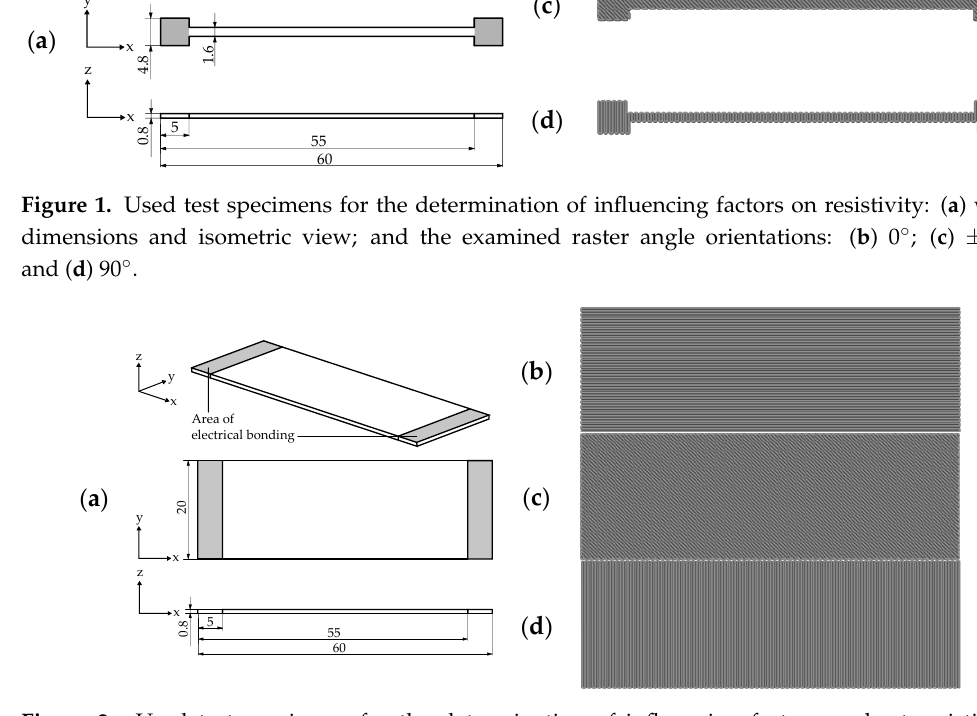
Figure 2. Used test specimens for the determination of influencing factors on heat resistivity: ( a ) with dimensions and isometric view; and the examined raster angle orientations: ( b ) 0°; ( c ) ±45°; and ( d ) 90°.